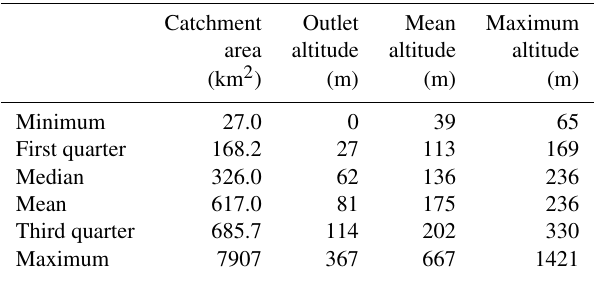
22 of them with 2; 8 of them with 3; 1 of them with 4; and 3 Table 1. Geographical characteristics of the 107-catchment